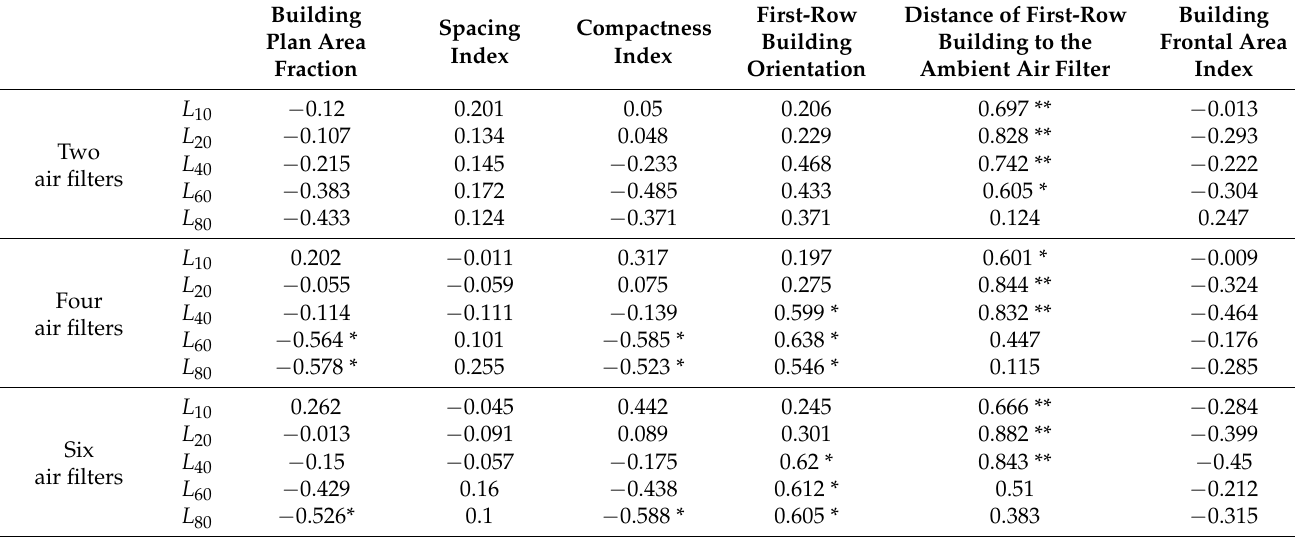
Table 6. Correlations between noise indices and urban form